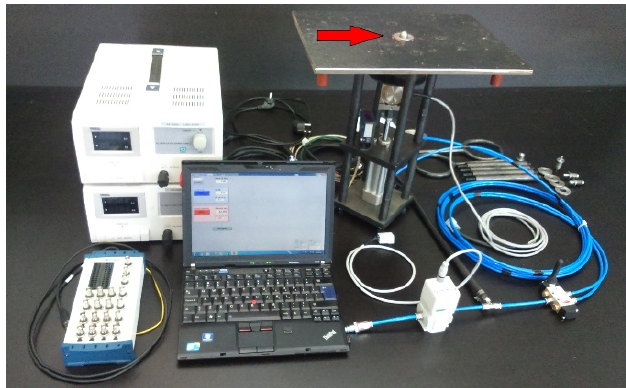
Figure 8. Device for investigation of tire tread deflections caused by pavement protrusions.